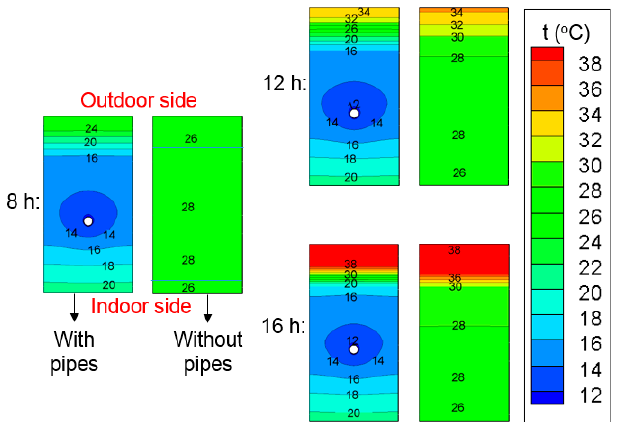
Figure 7. Temperature field of a wall during typical times of a day.